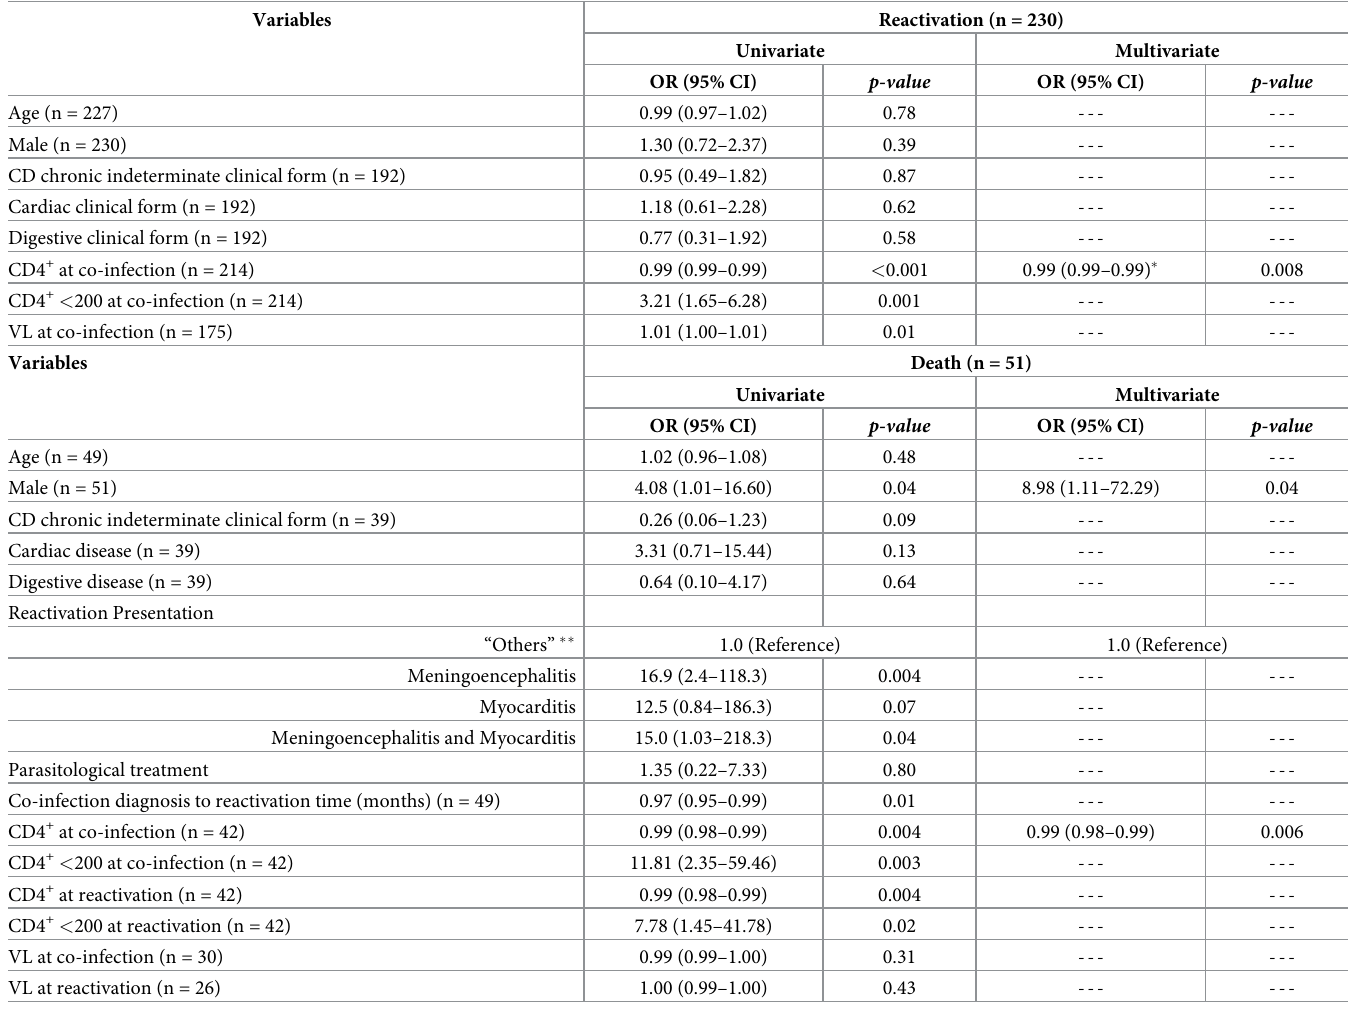
Table 5. Logistic regression model for association between clinical and demographical variables with reactivation outcome (n = 230) and death among those patients that presented CDR reactivation (n =